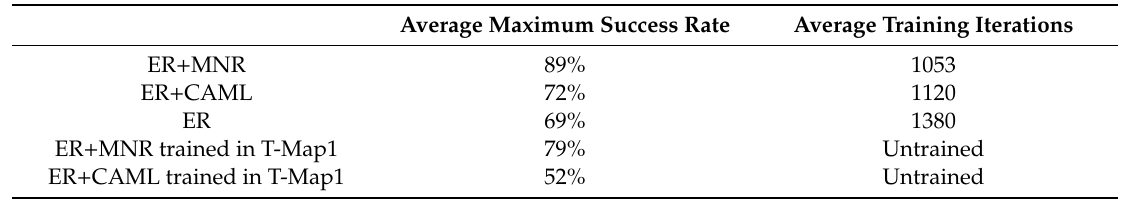
Table 4. Success rate under dynamic